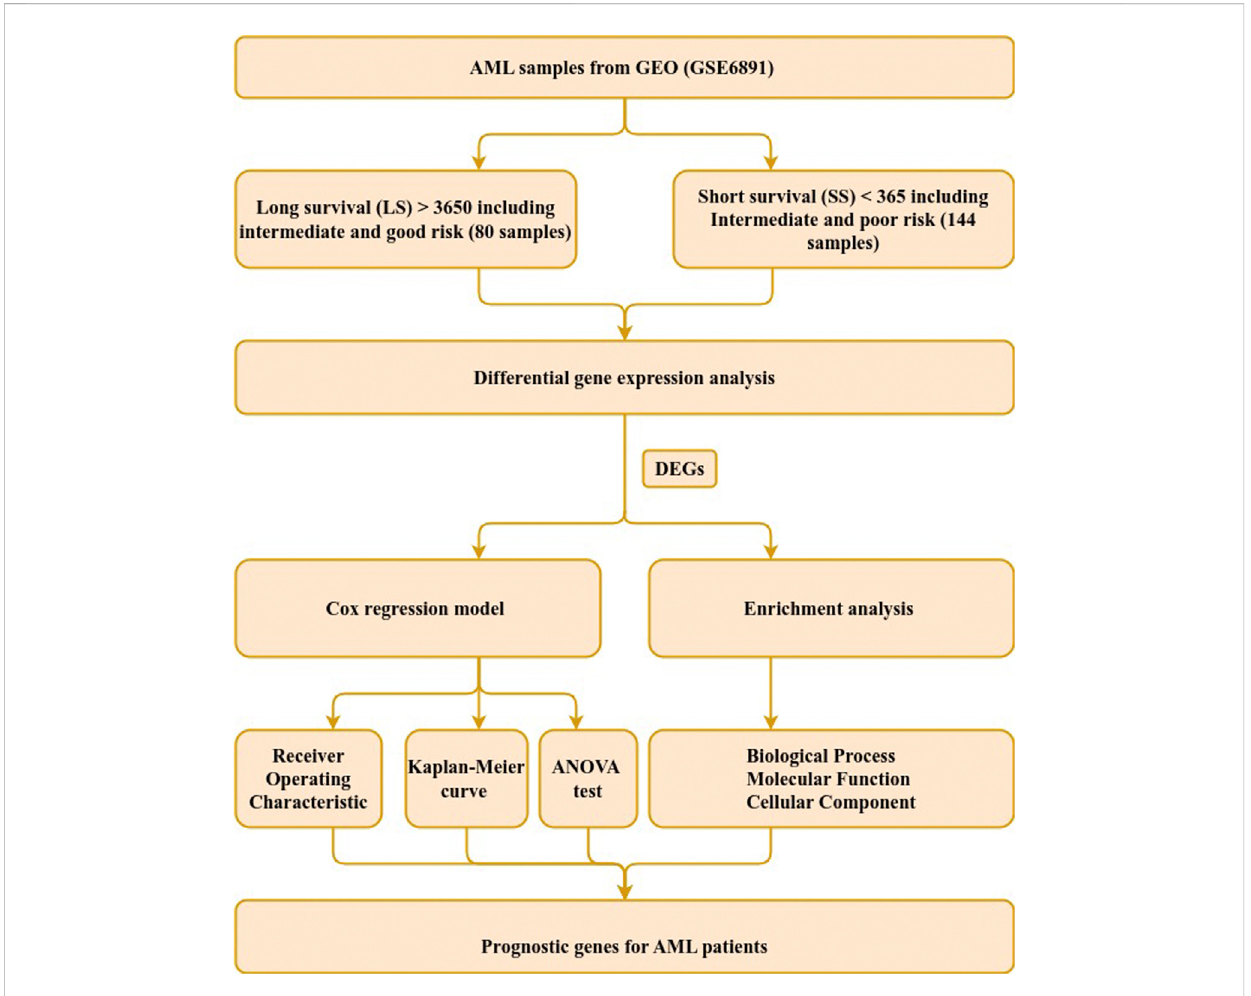
FIGURE 1 Study work fl ow. Steps used to identify genetic signature in AML patients with intermediate-risk. The steps comprise data extraction, sample grouping, differential gene expression, survival and functional enrichment analyses. DEGs refer to differentially expressed